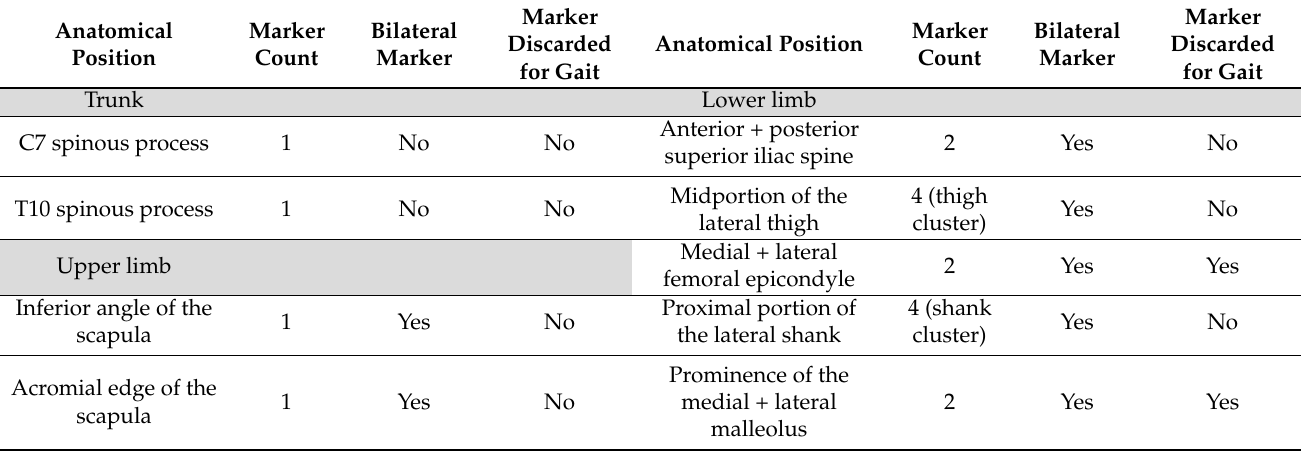
Table 1. Positioning of reflective markers above anatomical structures.